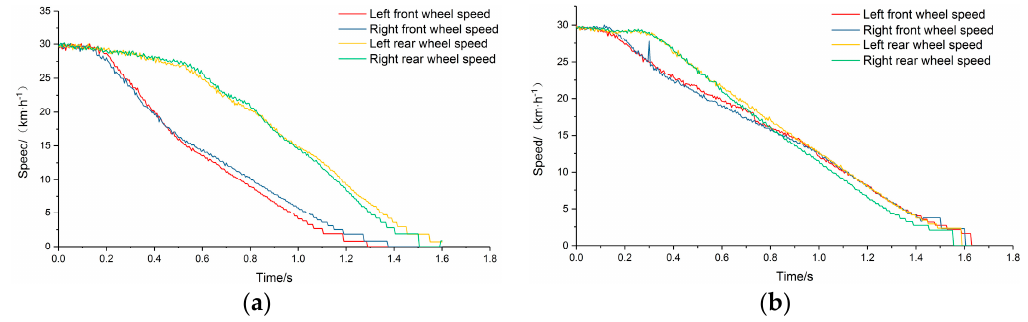
Figure 15. ( a ) Mechanical inertia compensation; ( b ) electromechanical inertia compensation.